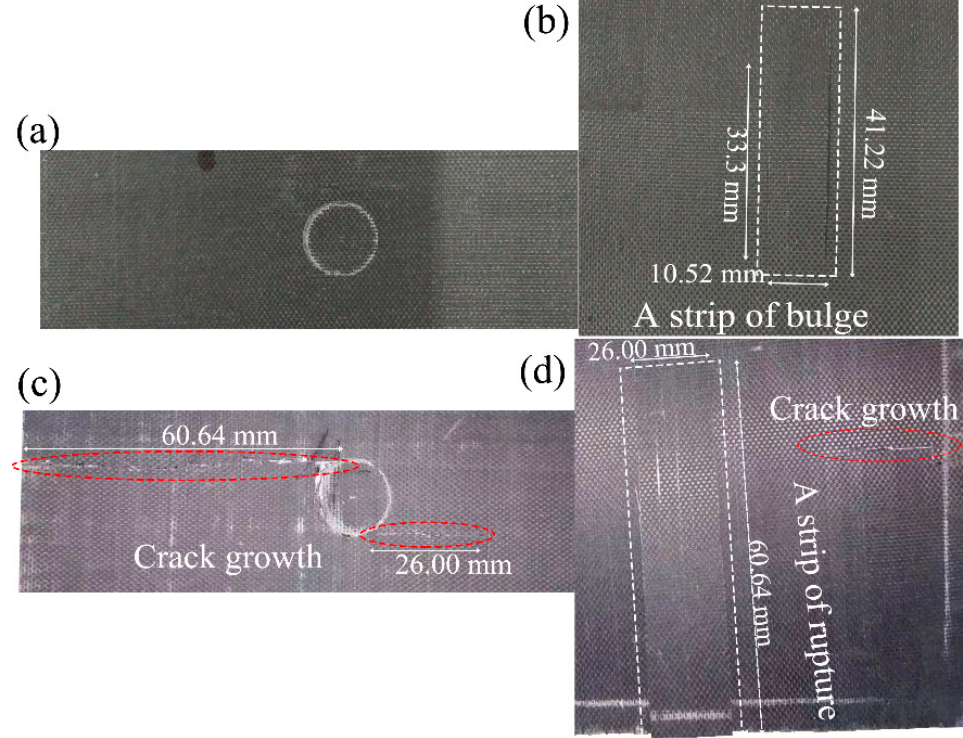
Figure 7. Photos of ( a ) the front and ( b ) back faces of a dry specimen, ( c ) the front and ( d ) back faces of a saturated specimen under an impact velocity of 68 m/s with the flat-ended projectile.